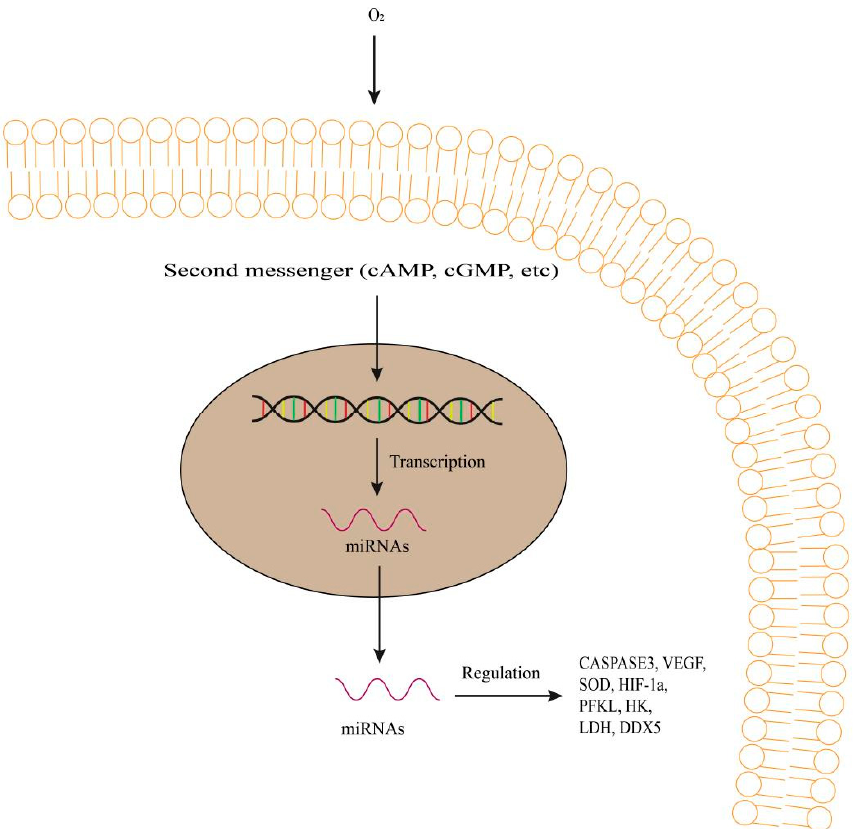
Figure 3. Regulation of CASPASE3, VEGF, SOD, HIF-1a, PFKL, HK, LDH and DDX5, etc., by miRNAs under oxygen concentration in fish. Second messengers induce the transcription of DNA. miRNAs regulate gene expression and function in target genes. They regulate transcription of the target genes and protein synthesis. VEGF, mean vascular endothelial growth factor; SOD, superoxidase dismutase; HIF-1a, mean hypoxia-inducible factor 1a; HK, mean hexokinase; LDH, mean lactate dehydrogenase; DDX5, mean DEAD-Box Helicase 5.